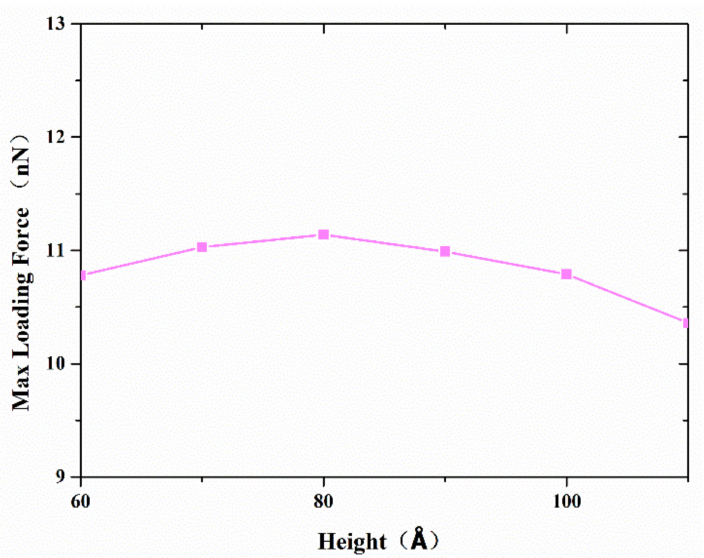
Figure 10. Effect of height of the cone on the strength of the formed joints between two cones with diameter 80 Å, separation distance 20 Å, and contact length 20